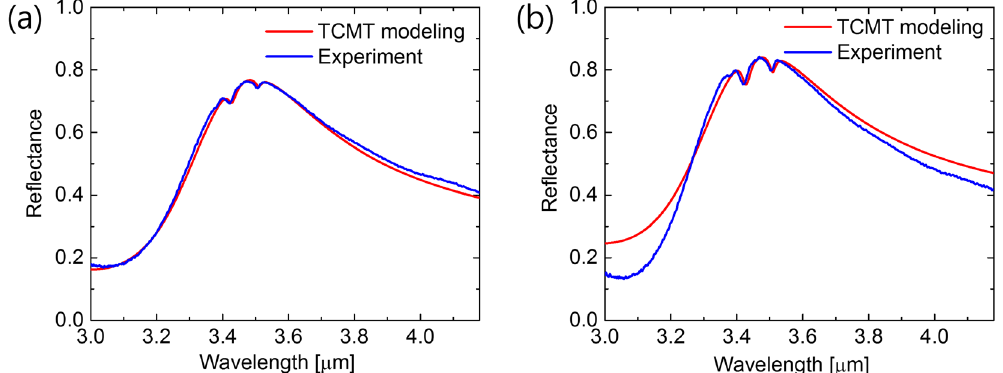
Figure 5. Experimental (blue) and TCMT fittings (red) of the reflection spectra for ( a ) the ODT-coated control FMM structure with L 1 = 680 nm and ( b ) the ODT-coated FMM on the nanopedestal structure with L 1 = 740